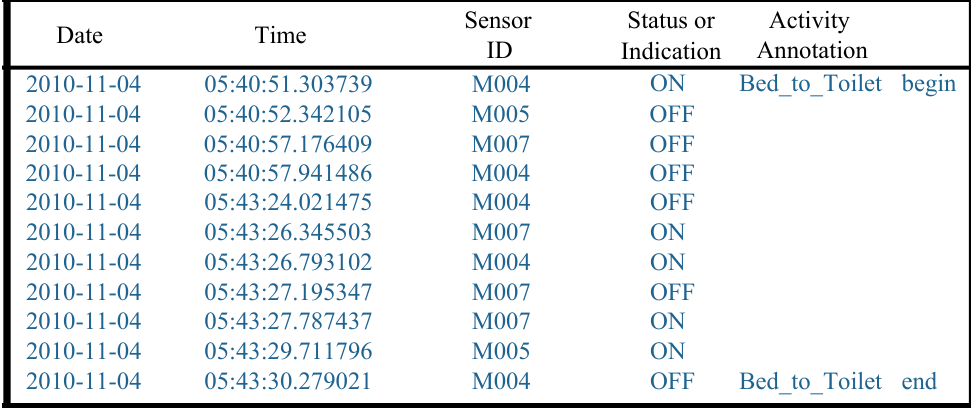
Figure 2. A sample of ARUBA’s raw